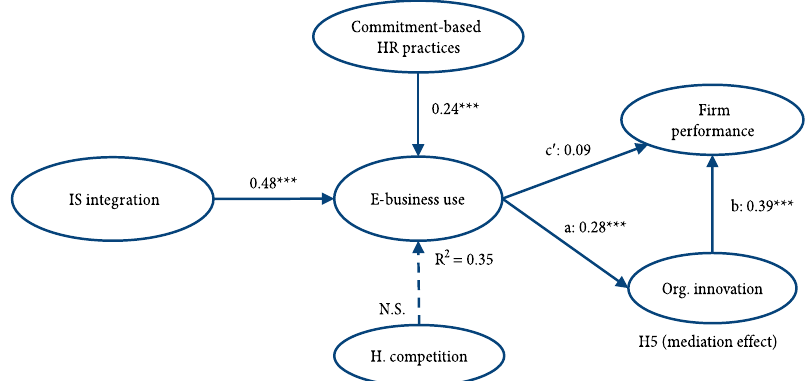
Fig. 2. Results for the